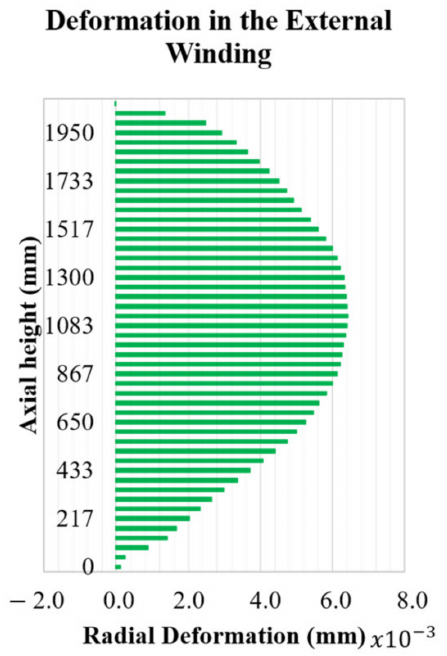
Figure 13. Deformation of the external